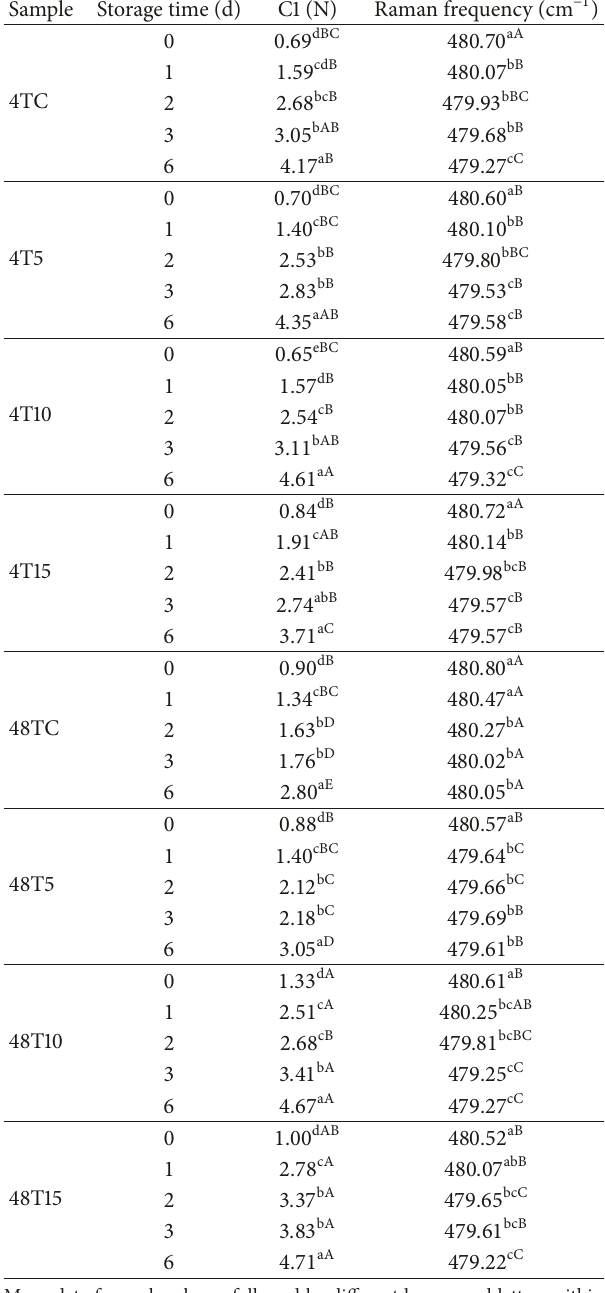
Table 5: Staling of pan bread: data from texture analysis and Raman